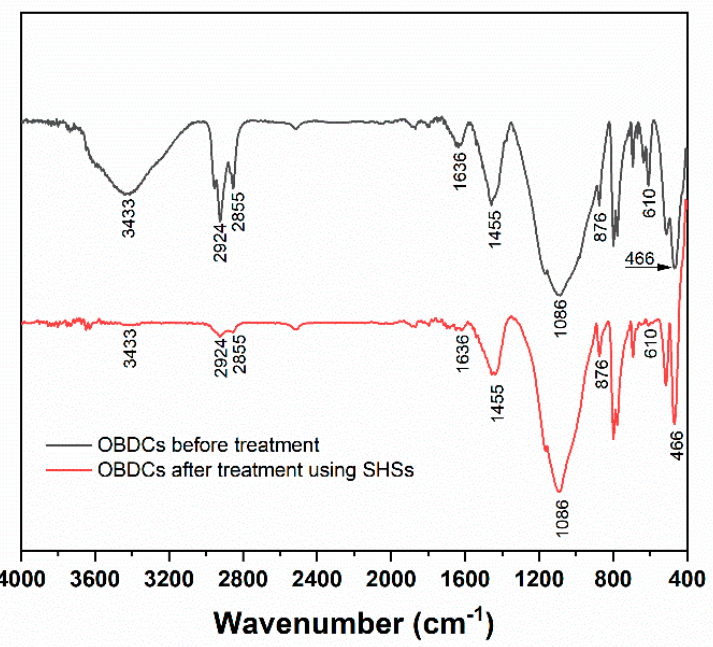
Figure 6. FT–IR spectrums of the shale gas OBDCs before and after treatment using SHSs.